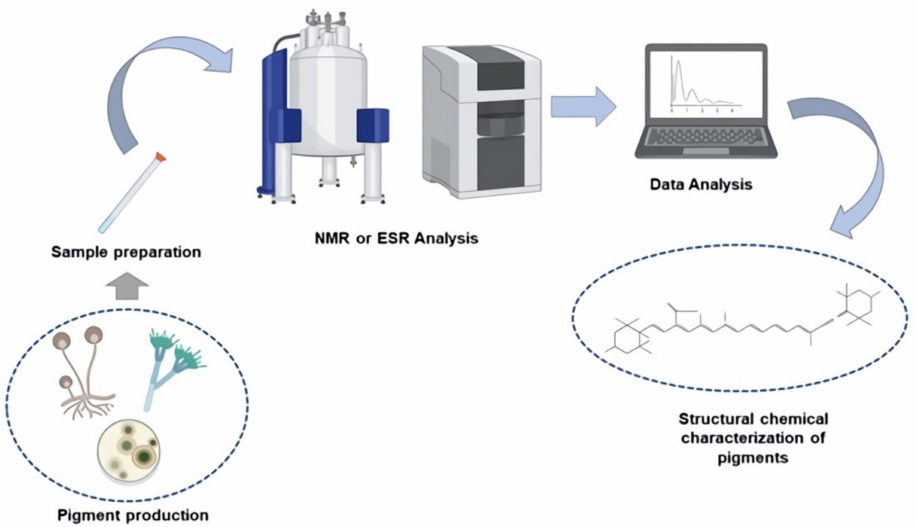
Figure 2. A general diagram of the fungal pigment analysis protocol using NMR and